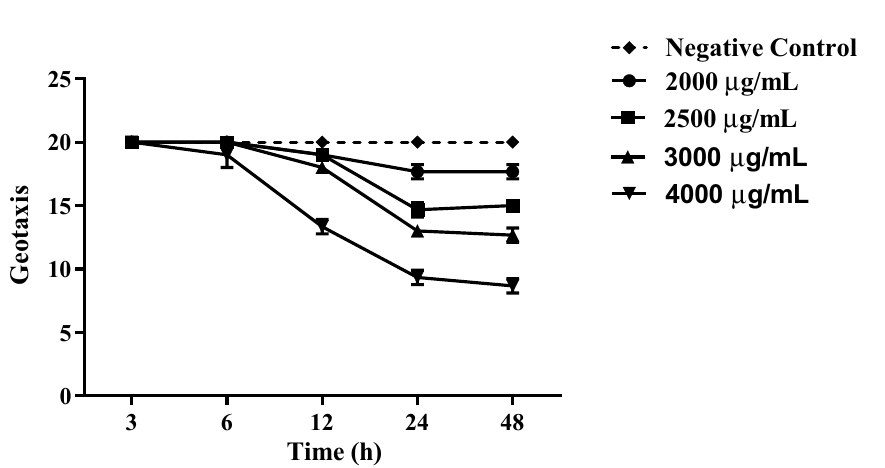
Figure 3. Negative geotaxis test in Drosophila melanogaster when exposed to different concentrations of L. sidoides aqueous extract in 48 h compared to the control